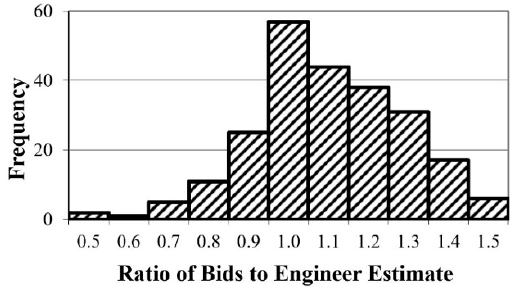
Figure 7. Ratio distribution of bids to engineer estimate.